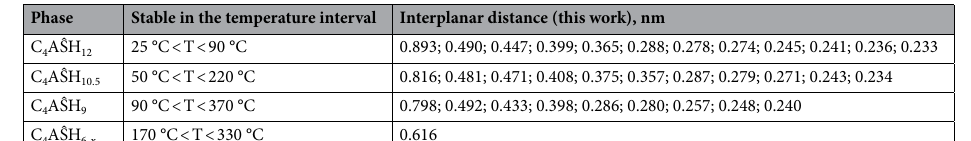
Phase Stable in the temperature interval Interplanar distance (this work),